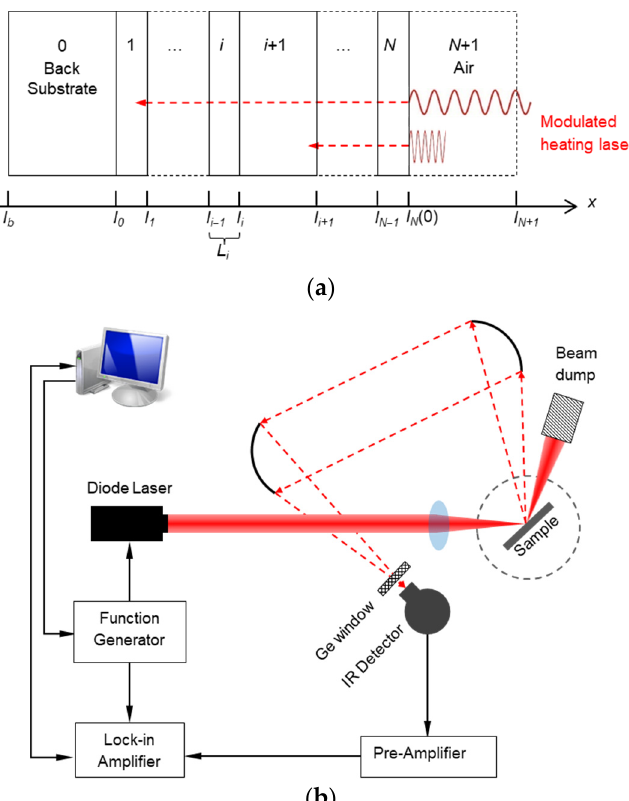
Figure 1. Physical schematics of PT technique: ( a ) mechanism of modulated heating and 1D heat conduction across the multilayered structure; ( b ) a typical experimental setup for PT technique.